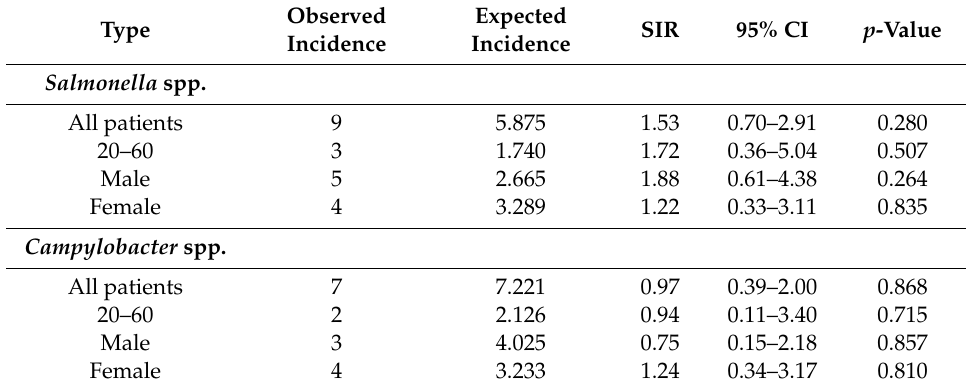
Table 5. Incidence of biliary tract cancer in patients ≥ 1 year after laboratory-confirmed infection